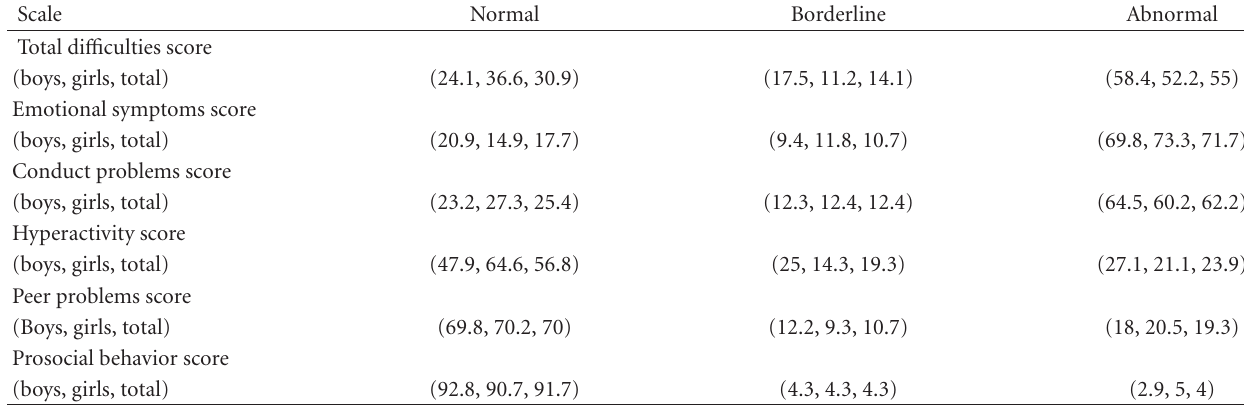
Table 2: Percentage of children in normal, borderline, and abnormal